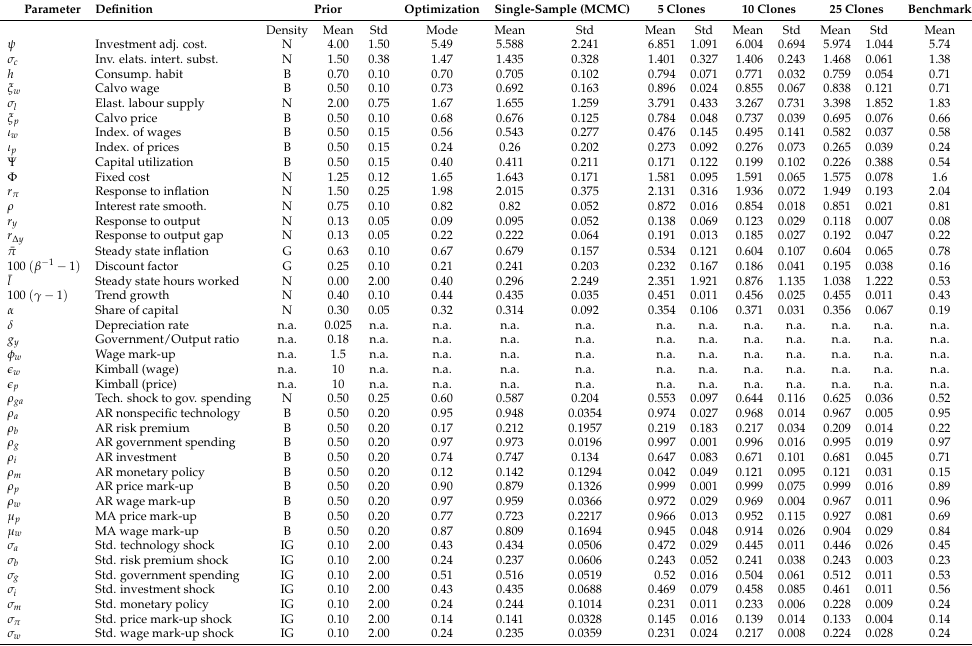
Note: table displays posterior estimates of the SW model. In the priors, specification N corresponds to a Normal distribution, B a Beta distribution, G a Gamma distribution, and IG an Inverse-Gamma distribution. The Single- Sample columns are the results of the usual estimation by MCMC. Calibrated parameters are represented by “n.a.”